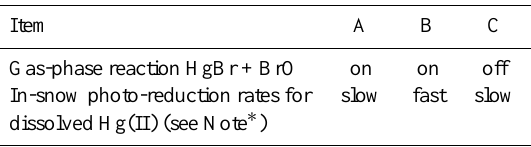
Table 3. Scenario sub-category for the sensitivity study of the mer- cury chemical